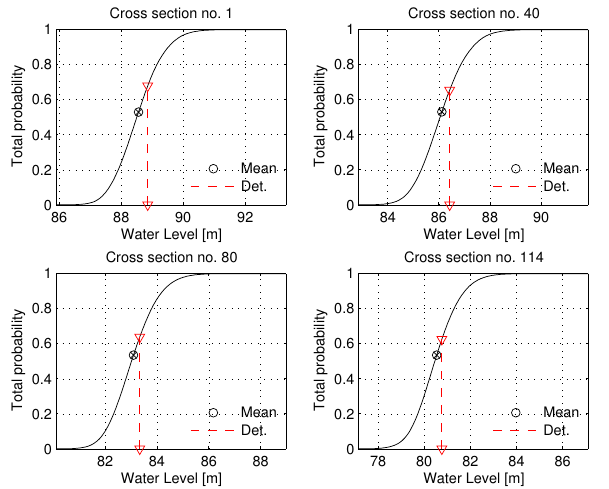
Fig. 8. The marginal cumulative probability density function of wa- ter levels at the MSS model cross sections (1, 40, 80 and 114) lo- cated along the Warsaw reach of the River Vistula for a 1-in-100 yr flood event flood event; solid lines show the distribution of water levels obtained using the GLUE framework; red dashed lines show the deterministic solution; mean values of water levels are shown by black circles.